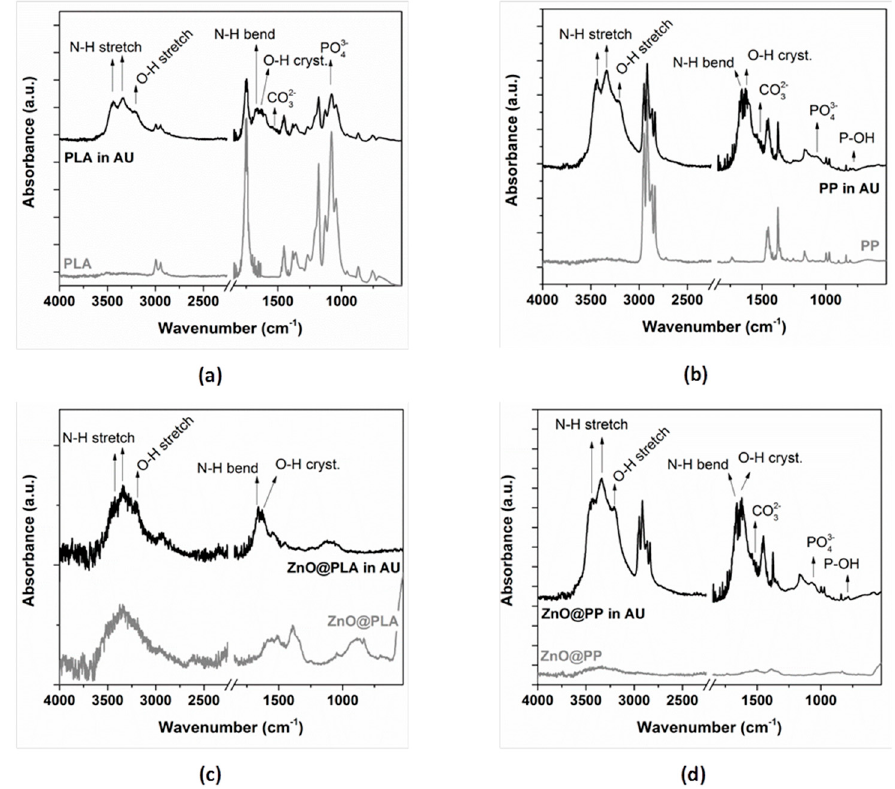
Figure 22. ATR-IR spectra of the samples after immersion in artificial urine for 21 days: ( a ) only PLA; ( b ) only PP; ( c ) ZnO@PLA; ( d ) ZnO@PP.